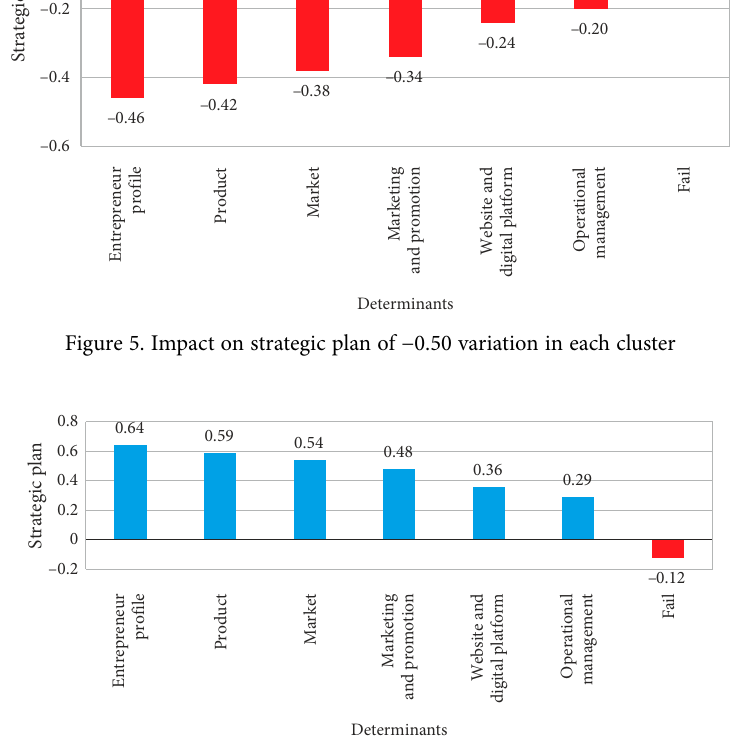
Figure 6. Impact on strategic plan of 0.75 variation in each cluster